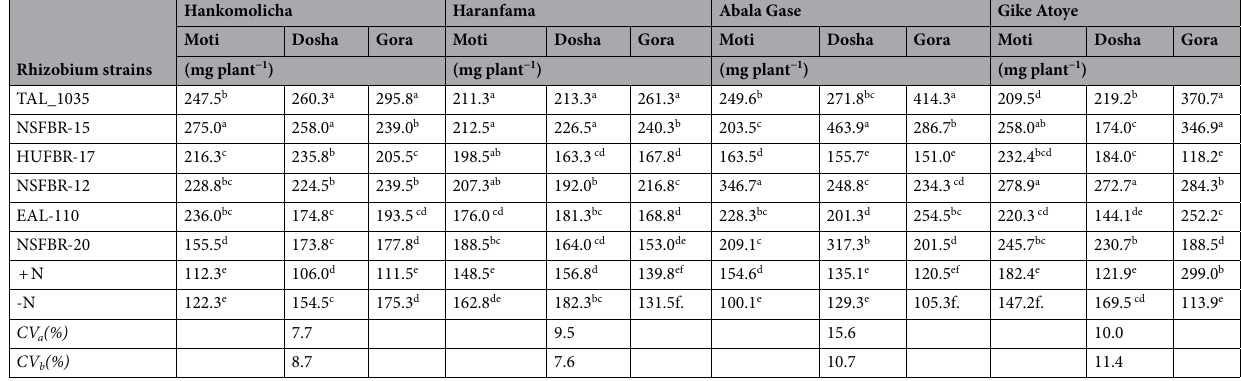
Rhizobium strains